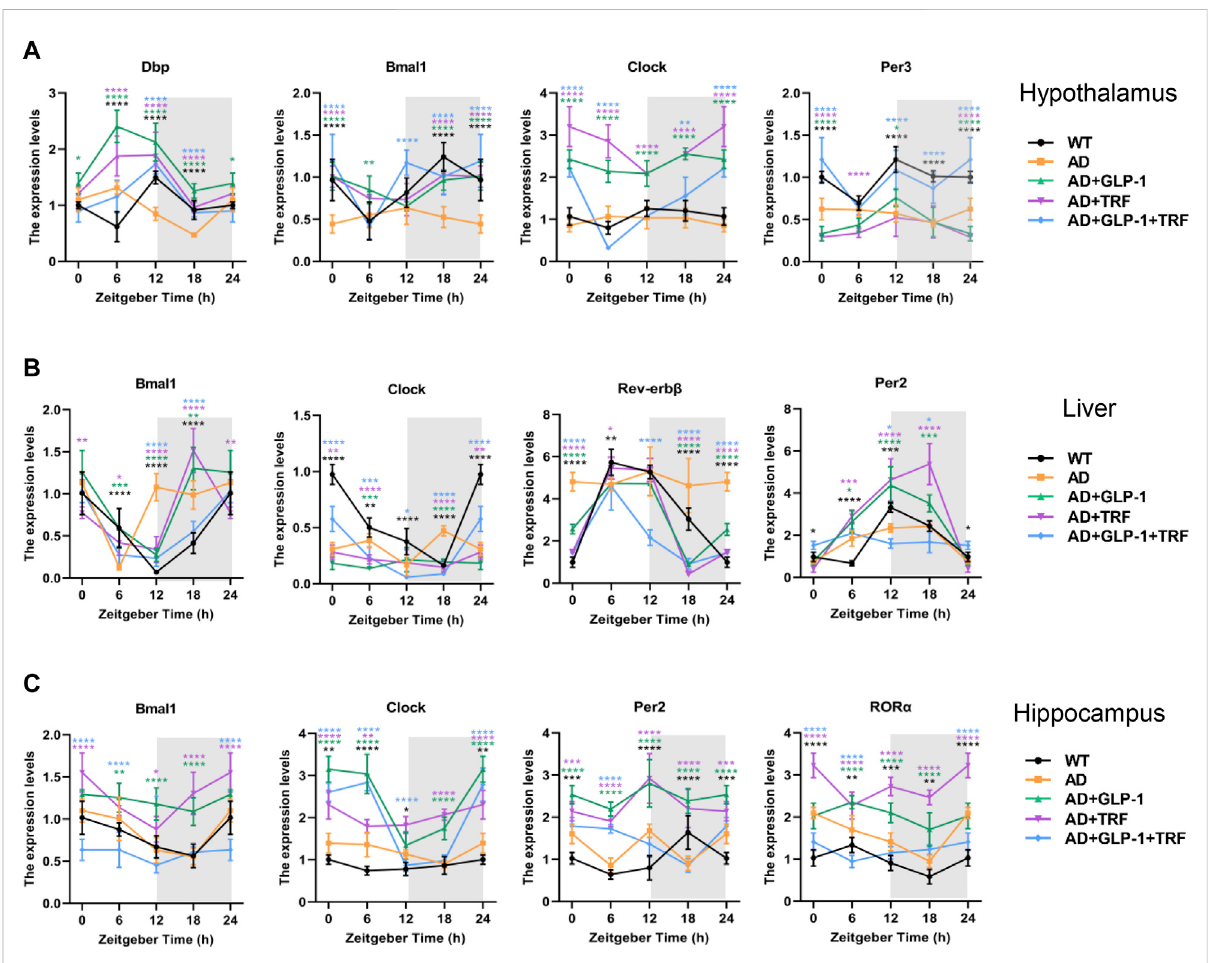
FIGURE 7 ImpactofGLP-1andTRFoncircadianrhythm-relatedgeneexpression. (A – C) Relativeexpressionlevelofcircadianrhythm-relatedgenesinthe hypothalamus, liver and hippocampus tissues at four time points throughout the day, respectively. * p < 0.05, ** p < 0.01, *** p < 0.001, **** p < 0.0001 vs. AD group, using two-way ANOVA followed by Dunnett ’ s test. n ≥ 5 per time point and per